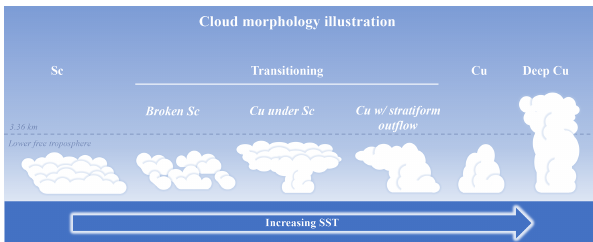
Figure 1. Illustration representing the different cloud morpholo- gies used in this study. The blue dashed line denotes the upper limit of the low-level clouds following the GOCCP definition (3.36km). Note that the deep Cu type is not a low cloud but either a mid- or high-level